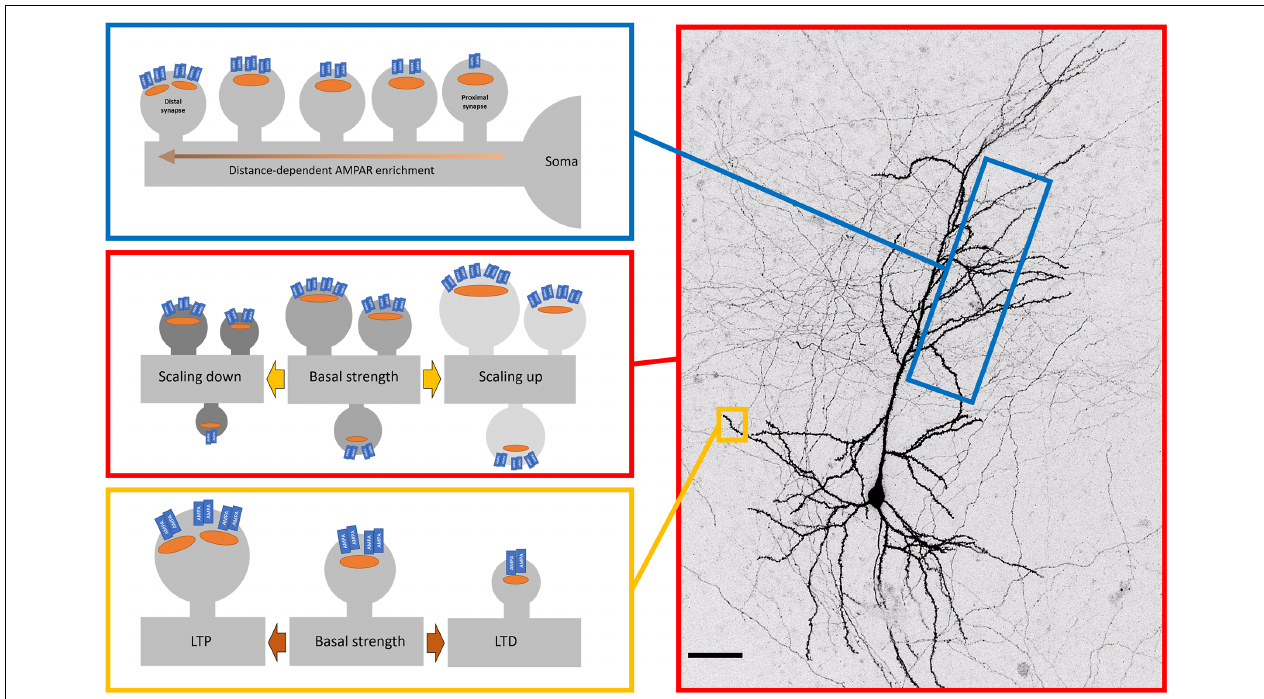
FIGURE 2 | Patterns of AMPAR organisation and plasticity across the neuron. Surface AMPAR distribution is regulated by plasticity across different spatial levels. Top—in CA1 neurons, synaptic AMPAR levels increase along dendrites as the distance from the soma increases. This distance-dependent scaling offsets the dendritic filtering of distal inputs. Middle—Cell-wide AMPARs are modulated by changes in global activity levels. Blocking activity causes a compensatory increase in synaptic AMPAR levels (scaling up). Similarly, the increasing activity causes a down-scaling of AMPARs. These changes are multiplicative, thereby retaining the relative strengths encoded in synapses. Bottom—Activity-dependent trafficking of AMPARs. High-frequency stimulation increases levels of synaptic AMPARs that is one of the key cellular mechanisms of long-term potentiation (LTP). Low frequency simulation leads to loss of synaptic AMPARs (long term depression,